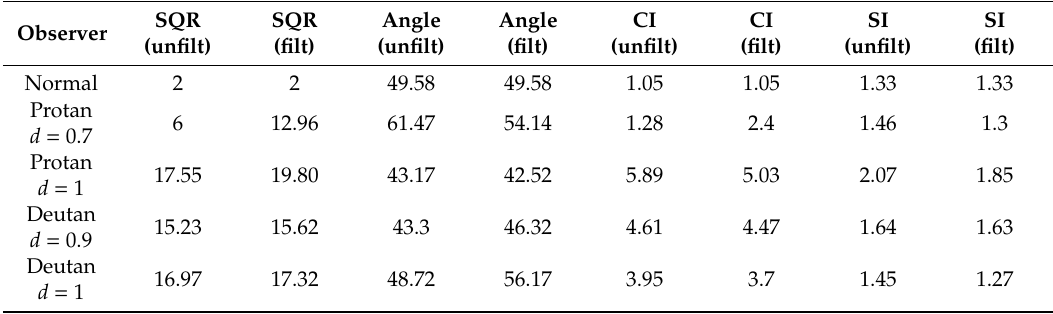
Table 5. Quadratic Total Error Score (SQR), Angle, C-Index, and S-Index computed for each simulated observer in the filtered (with the best-performing filter) and unfiltered